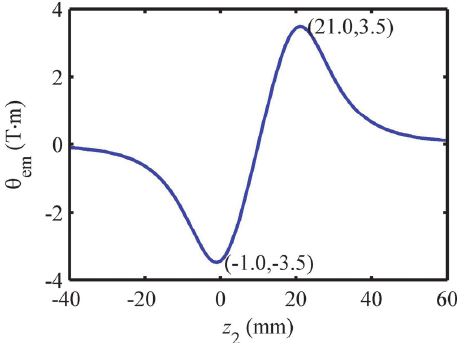
Figure 3. Electromagnetic coupling coefficient versus z 2 .